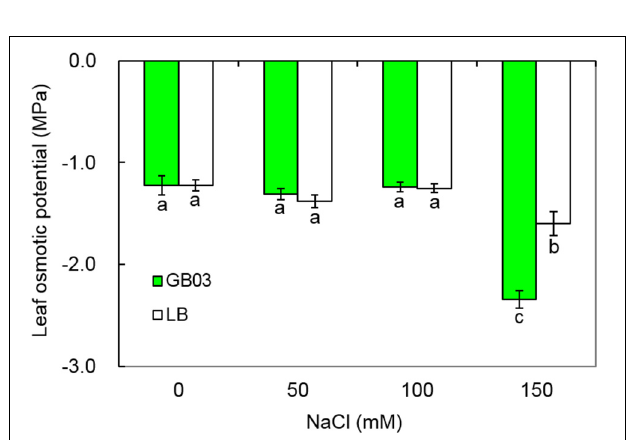
FIGURE 5 | Effects of GB03 bacterization on leaf osmotic potential of white clover under various concentrations of NaCl. Values are means and bars indicate SDs ( n = 8). Columns with different letters indicate significant difference at P < 0 . 05 (Duncan test).